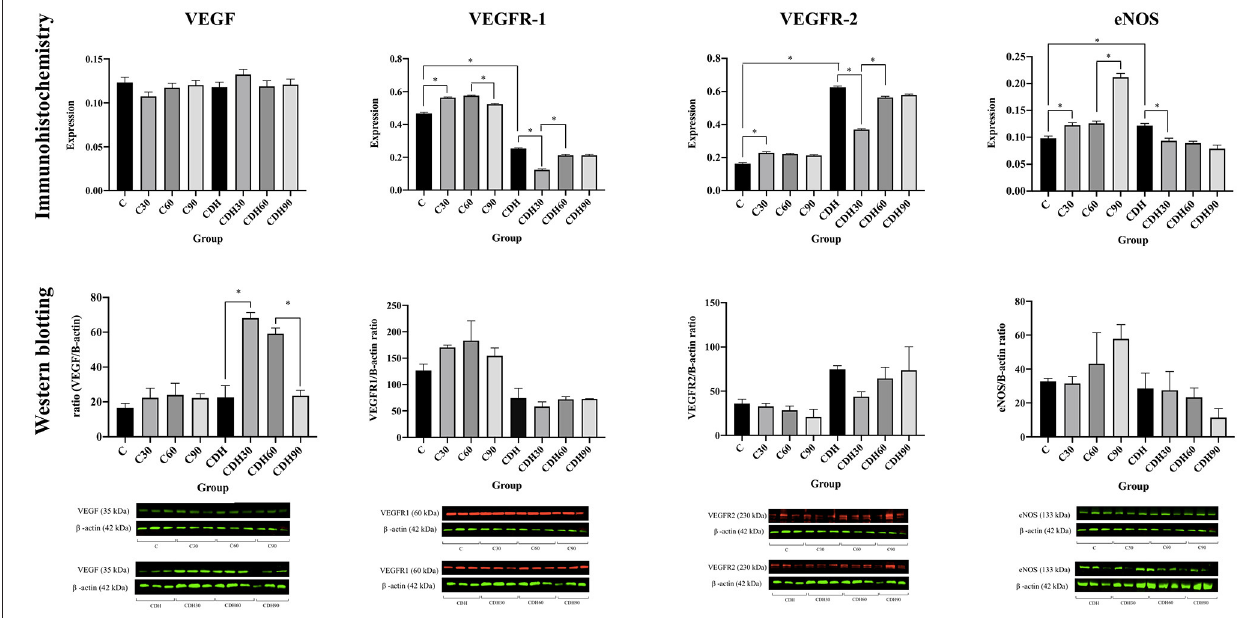
FIGURE 4 | VEGF, VEGFR-1, VEGFR-2, and eNOS immunostaining and Western blotting counts. VEGF, VEGFR-1/2 and eNOS immunostaining and western blotting counts per group. C, control; C30, control ventilated for 30min; C60, control ventilated for 60min; C90, control ventilated for 90min; CDH, congenital diaphragmatic hernia; CDH30, CDH ventilated for 30min; CDH60, CDH ventilated for 60min; CDH90, CDH ventilated for